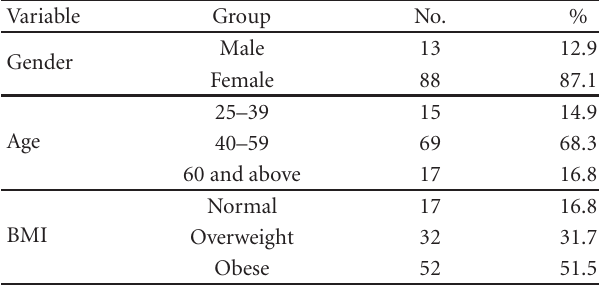
Table 1: Distribution of respondents according to age, gender,